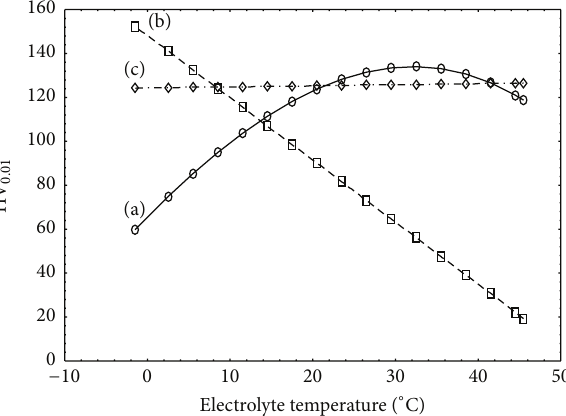
Figure 7: The dependence of the layer microhardness on the tem- perature of the electrolyte: c (H 2 SO 4 ) = 1.43 mol ⋅ L −1 , c (C 2 H 2 O 4 ) = 0.06 mol ⋅ L −1 , U = 10V, t = 1.22 min. (a) 1A ⋅ dm −2 , (b) 3A ⋅ dm −2 , and (c) 5 A ⋅ dm −2 .